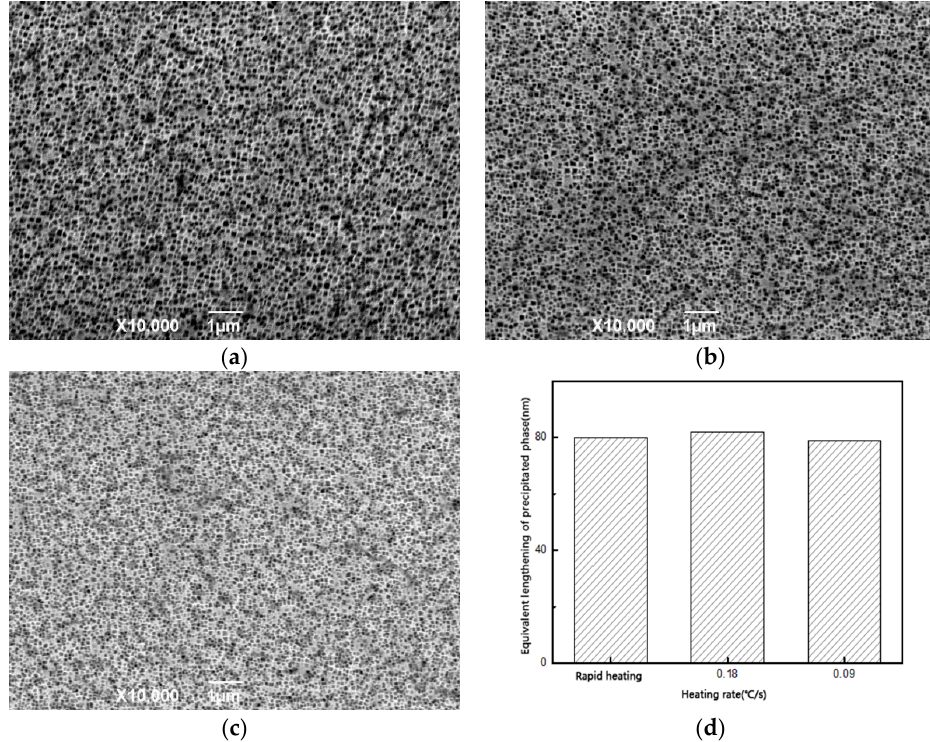
Figure 5. Microstructure of the γ / γ ´ phase after cooling by solution treatment at different temperature rising rates ( a ) Rapid heating, ( b ) 0.18 °C/s, ( c ) 0.09 °C/s, ( d )Average equivalent side length of precipitated phase.